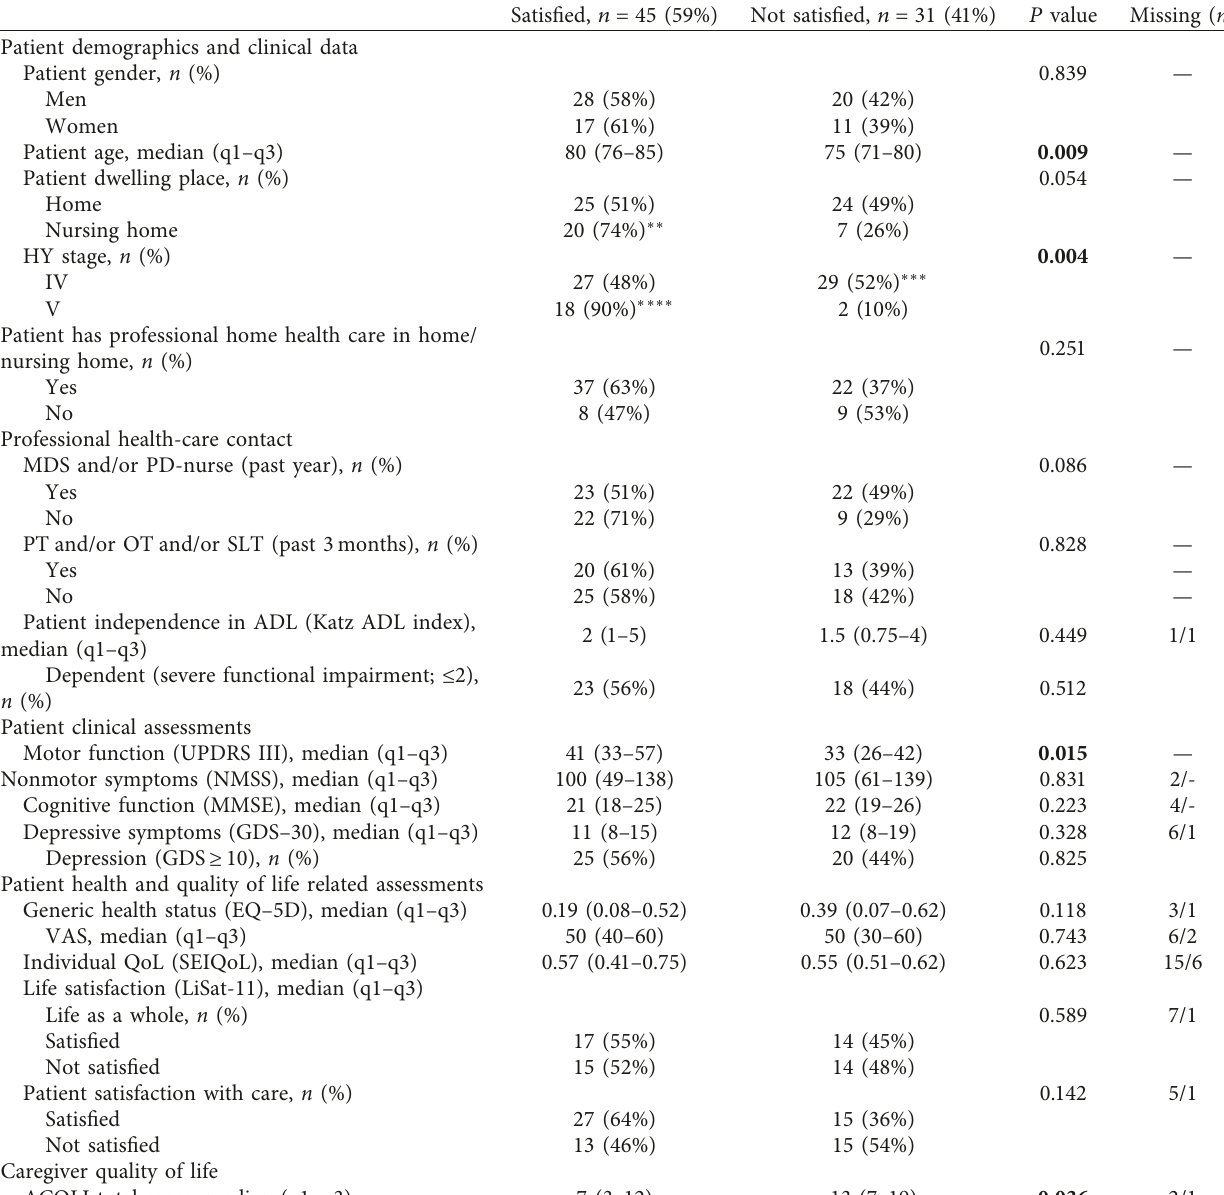
Table 3: Univariate associations with informal caregivers’ satisfaction with support ( n � 76 ∗